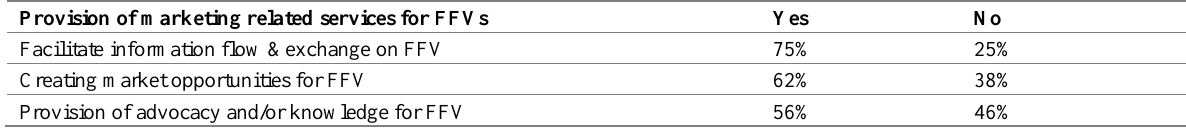
Table 5: Summary of Provision of Marketing Related Services for